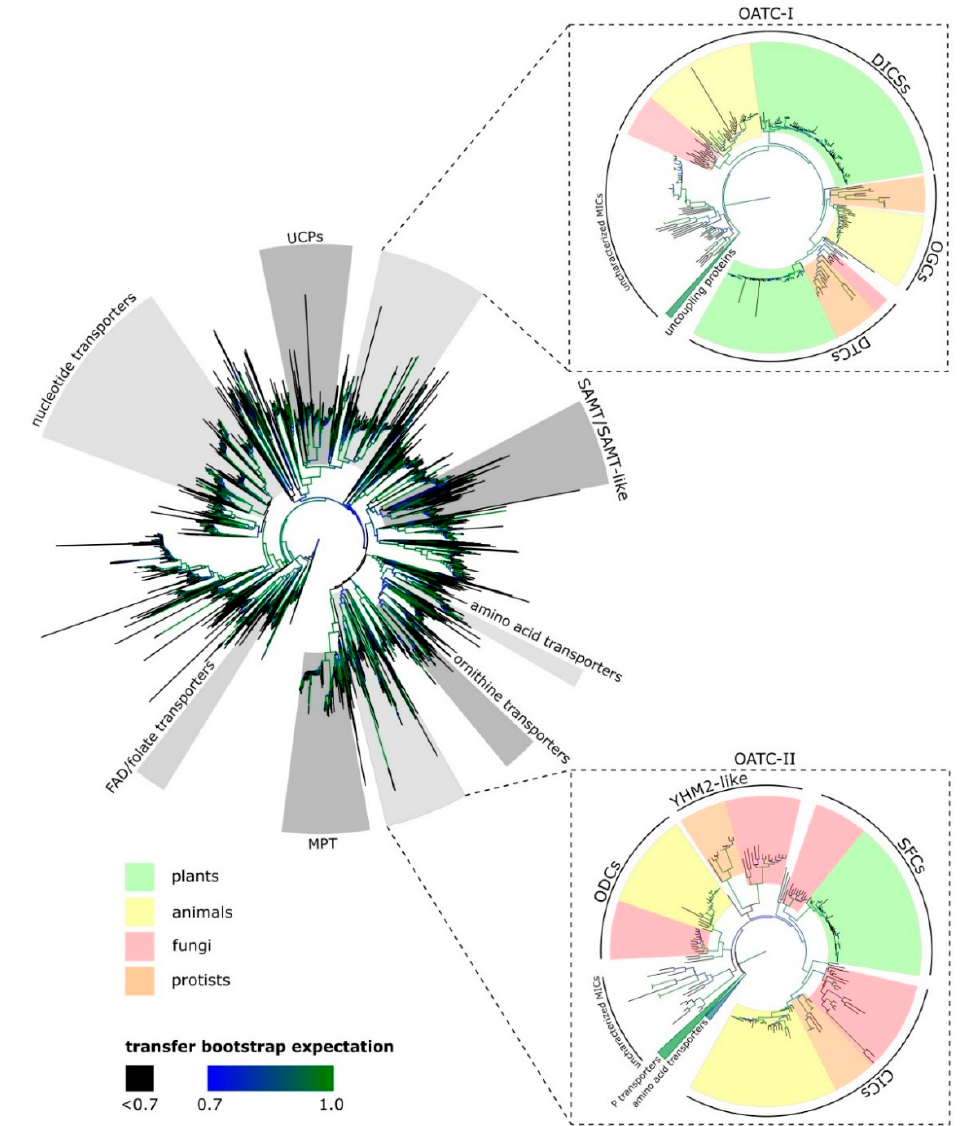
Figure 1. An unrooted phylogenetic tree of mitochondrial carrier families (MCFs) across Domain Eukaryota. The tree was inferred based on Maximum Likelihood using the RAxML software and visualized using iTOL ( https://itol.embl.de/ ), see text for details. UCP: uncoupling proteins, SAMT: S-adenosyl methionine transporter, OATC-I/II: organic acid transporters clade I/II, DICs: dicarboxylate transporters, OGCs: 2-oxoglutarate carriers, DTCs: dicarboxylate/tricarboxylate carriers, ODC: oxodicarboxylate carriers, YHM2-like: yeast HM mutant 2-like transporters, SFCs: succinate/fumarate carriers, CiCs: citrate transporters.